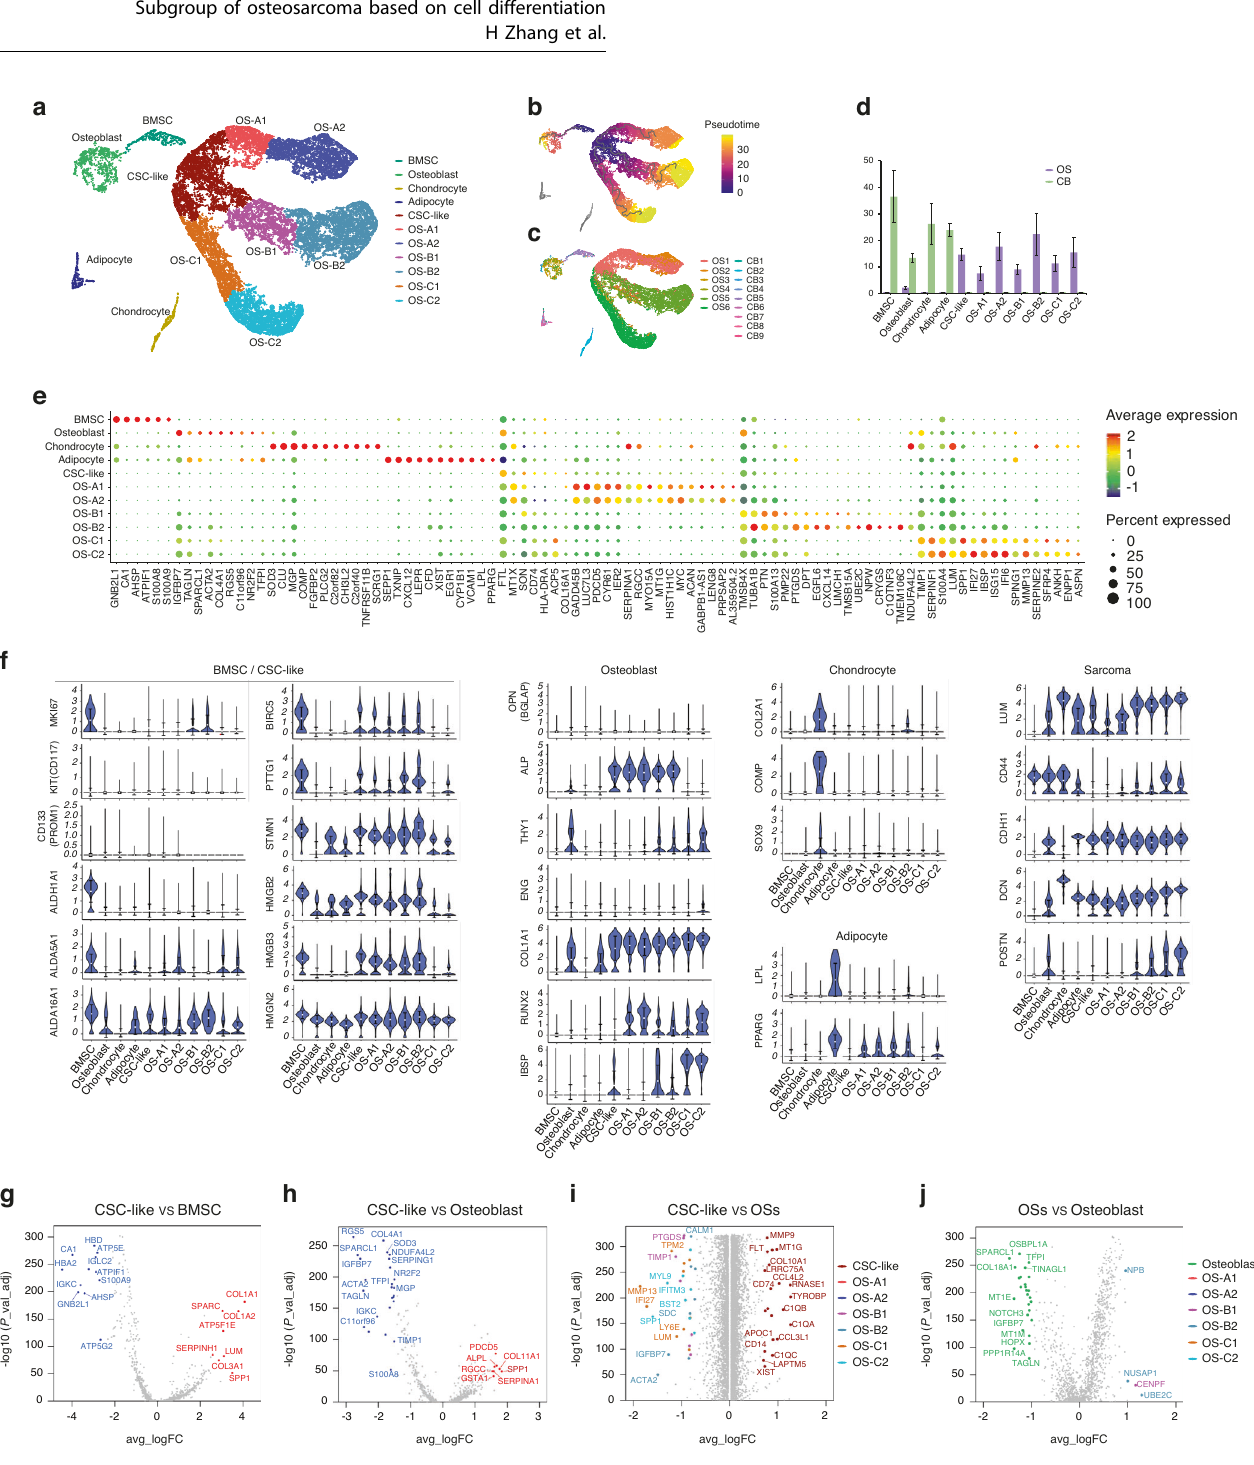
Fig. 2 Differences in cell composition and gene expression between OS and CB samples. a UMAP plot of mesenchymal cells by the Monocle3 method. b Pseudotime trajectory of mesenchymal cells. c UMAP plot of mesenchymal cells color-coded for each sample. d Differences in cell proportion between OS and CB samples in each mesenchymal cluster. e Dot-plot heatmap of the most signi fi cant genes of each cluster in mesenchymal cells. f Violin plots showing differential expression of stem cell, osteoblast, chondrocyte, adipocyte, and sarcoma markers in each mesenchymal cluster. g Differences in gene expression between CSC-like and BMSC clusters. h Comparison of gene expression between CSC-like and osteoblast clusters. i Differences in gene expression between the CSC-like cluster and total OS cells. j Differences in gene expression between total OS cells and osteoblasts. * P < We performed transcription factor (TF) analysis for the seven OS Moreover, clusters in the same differentiation branch shared cell clusters to reveal the transcriptional program during OS cell similar TF activation, whereas those in different branches differentiation. The results highlighted the relative activation of exhibited different TF activation, demonstrating that the transcrip- EZH2 and CTCF in CSC-like cells (Fig. 3i), which correlated with tional programs in the three differentiation trajectories are tumor cell stemness, proliferation, and drug resistance. 25,26 different (Fig. 3i, j). TF activation of the four normal mesenchymal